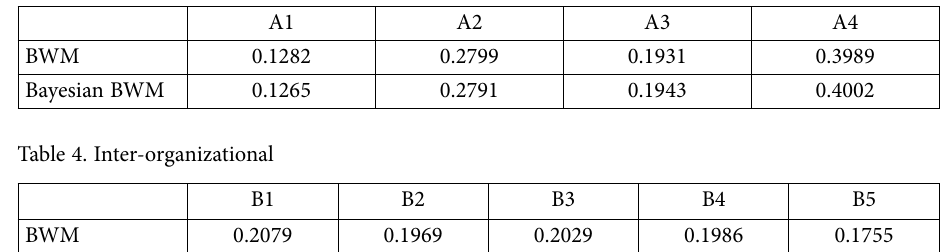
Table 3. Comparison between BWM and Bayesian BWM of applying BT to SCs barriers